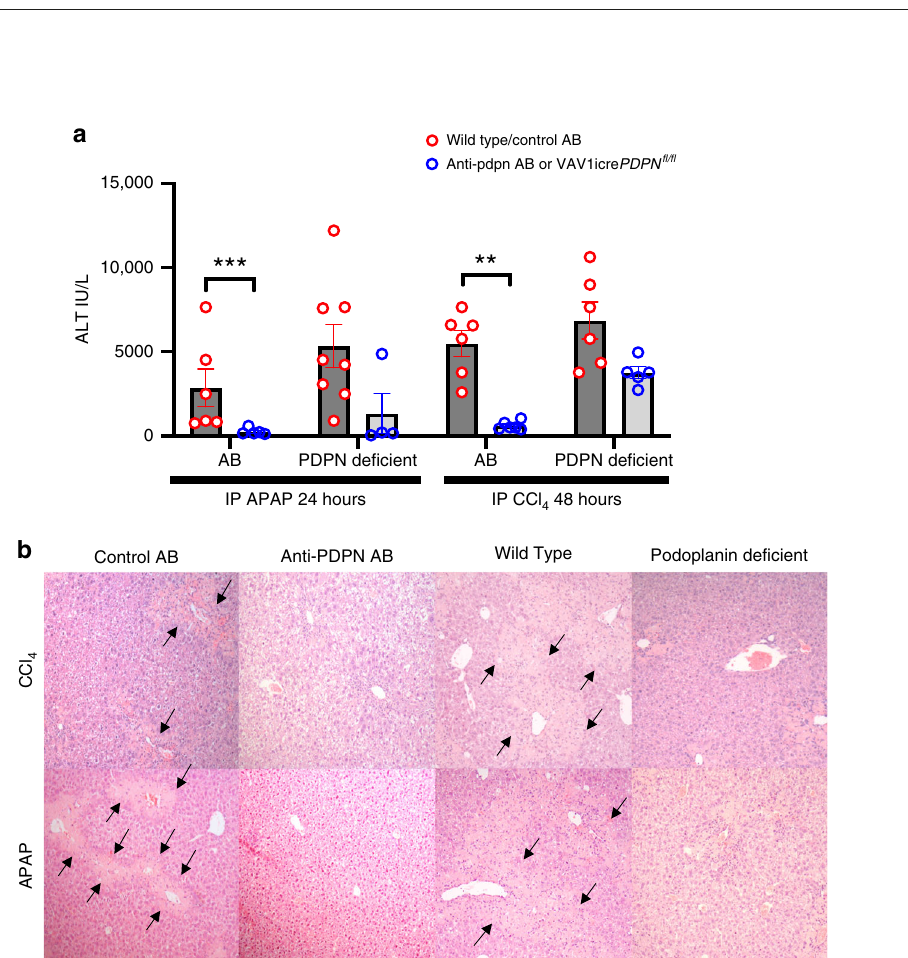
Fig. 3 Removing podoplanin removes the signal for platelet CLEC-2 signalling and enhances liver healing after CCl4 or APAP induced liver injury. WT (Cre negative) or podoplanin de fi cient (Vav1-iCre + pdpn fl / fl ) mice were injected with IP CCl 4 (1 mg/kg) and sacri fi ced at 48 h or IP APAP (350 mg/kg) and sacri fi ced at 24 h. a Serum ALT level is shown from mice treated with either APAP (acetaminophen) or CCl 4 , the fi rst and third pairs of